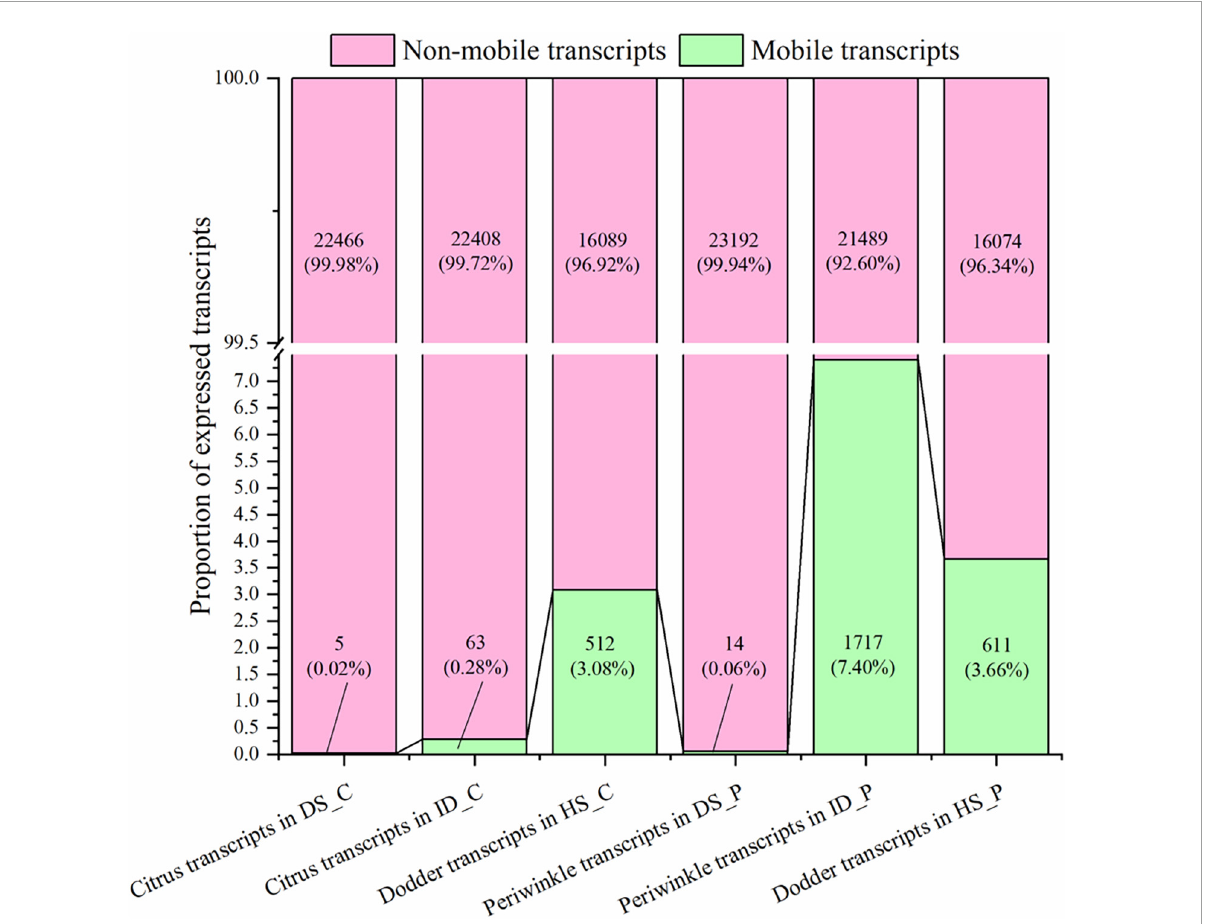
FIGURE2 Distribution and frequency of mobile and non-mobile transcripts in different tissues. DS_C: the growth extension portion of dodder stem near the region of attachment in citrus-dodder system; ID_C: interface region where dodder was connected to the citrus stem; HS_C: the citrus stem above the region of attachment site; DS_P: the growth extension portion of dodder stem near the region of attachment in periwinkle-dodder system; ID_P: interface region where dodder was connected to the periwinkle system; HS_P: the periwinkle stem above the region of attachment site. mRNAs with mapped reads ≥ 4 were identified as mobile transcripts (represent as green bar). Transcripts that detected in native tissue and not meeting the four reads threshold for mobility were classified as non-mobile (represent as pink bar). Both the number and proportion of transcripts were listed in the corresponding bar. The diagram was generated based on mRNA abundance by Origin